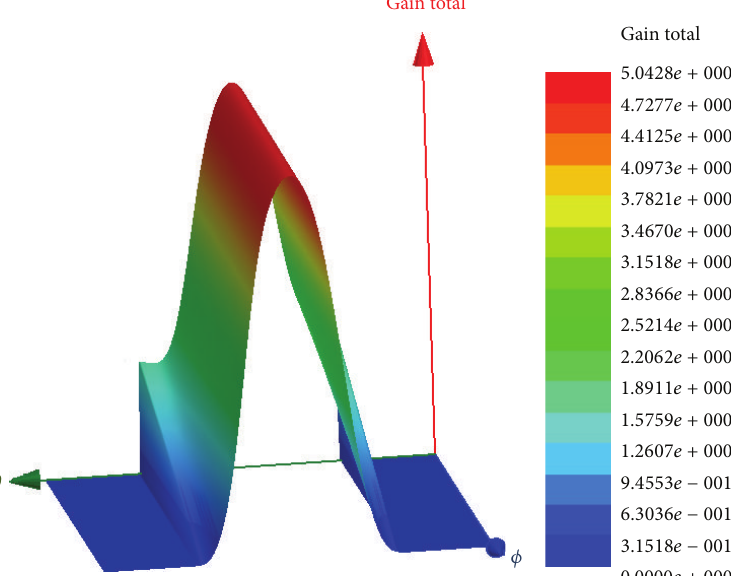
Figure 12: 3D gain of the CRA for the first iteration at 3.04 GHz.